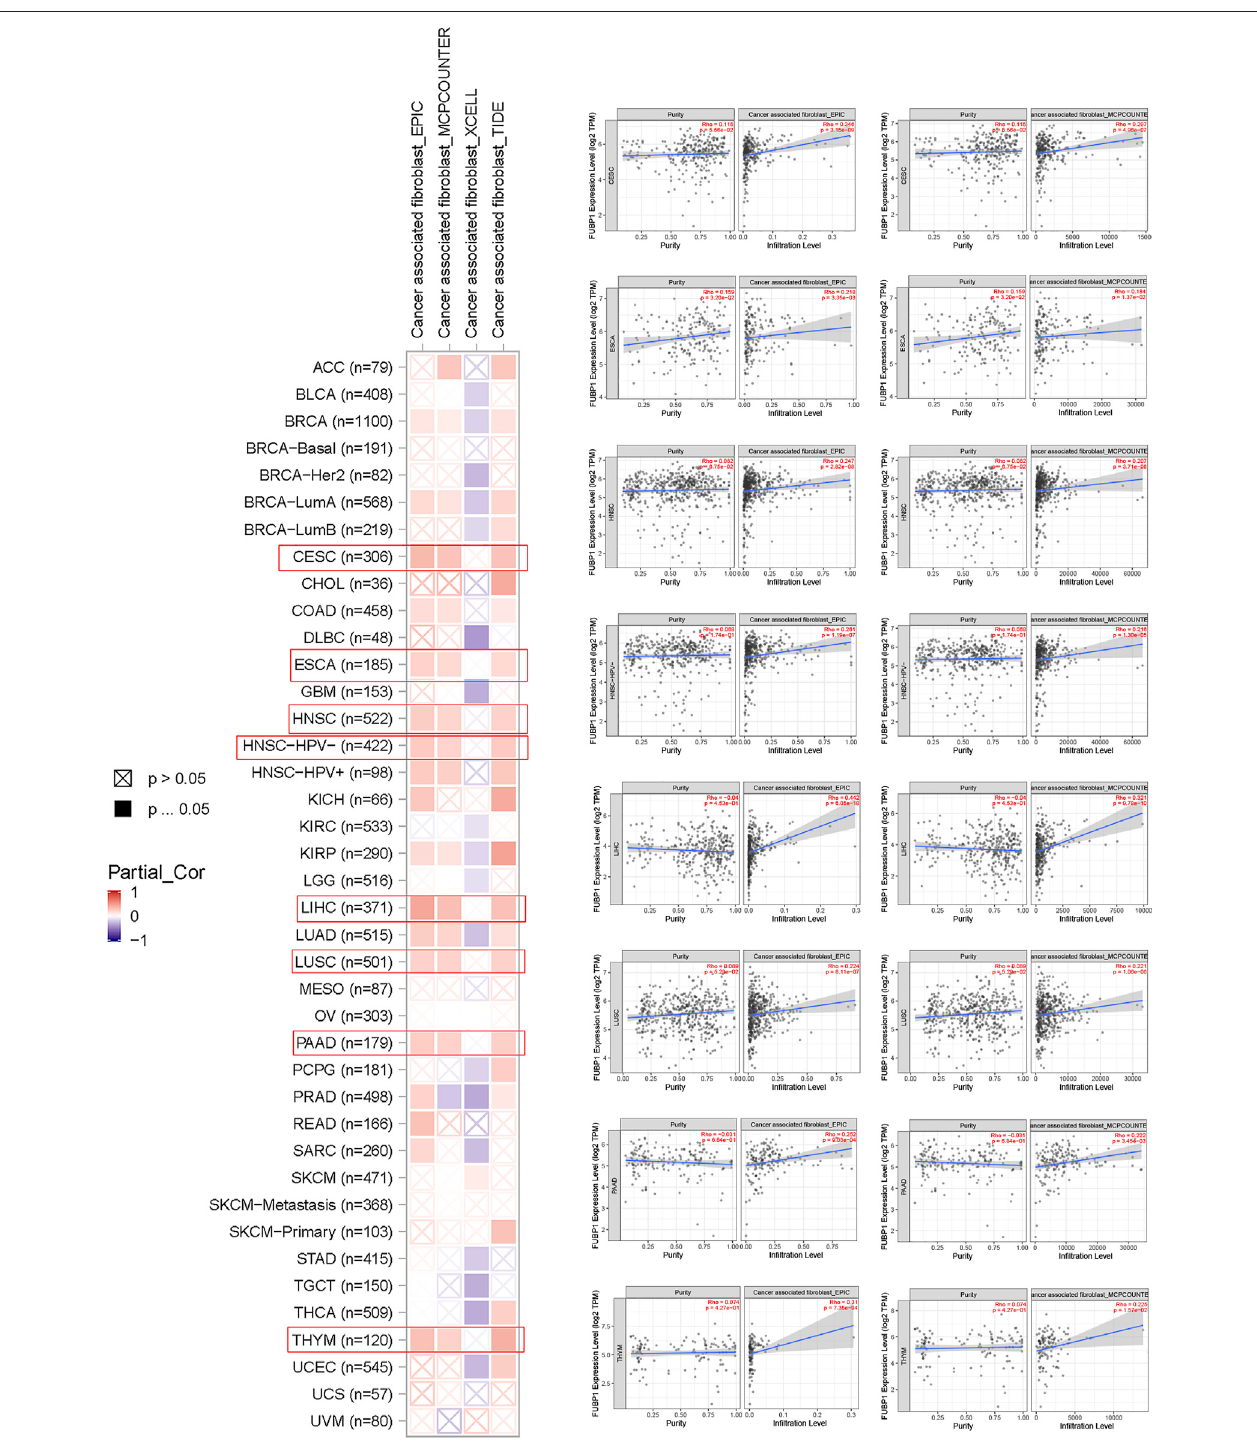
FIGURE 7 | Correlation analysis between FUBP1 expression and the immune in fi ltration of cancer-associated fi broblasts. Multiple algorithms were applied to explore the correlation between the expression of FUBP1 and the in fi ltration level of cancer-associated fi broblasts in different cancer types in TCGA.